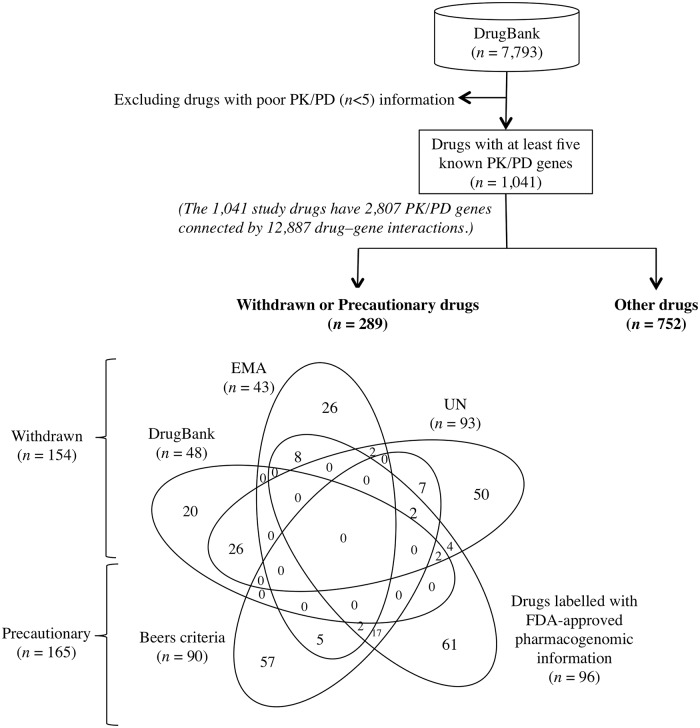
Inclusion criteria and distribution of withdrawn, precautionary, and other drugs.In total, 1041 drugs from the DrugBank with at least five identified genes involved in drug pharmacokinetics (PK) and pharmacodynamics (PD) were included in the study. A comprehensive list of withdrawn drugs (n = 154) was obtained by reviewing three resources: 1) the 8th, 10th, 12th, and 14th Issues of the ‘Consolidated List of Products Whose Consumption and/or Sale Have Been Banned, Withdrawn, Severely Restricted, or Not Approved by Governments: Pharmaceuticals’ published by the United Nations [18–21]; 2) applications for withdrawal from European Medicines Agency (EMA)[22]; and 3) the DrugBank annotations for withdrawals. Precautionary drugs (n = 165) were identified based on the Beers criteria [23] and US FDA table of pharmacogenomics biomarkers [11]. The remaining 752 drugs were classified as other drugs.